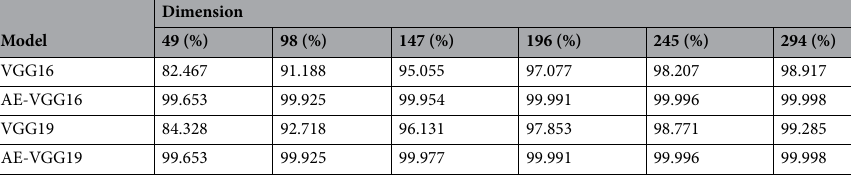
Table 2. The cumulative variance contribution rate corresponding to different feature dimensions selected by the feature extraction model. Significant values are in [bold]